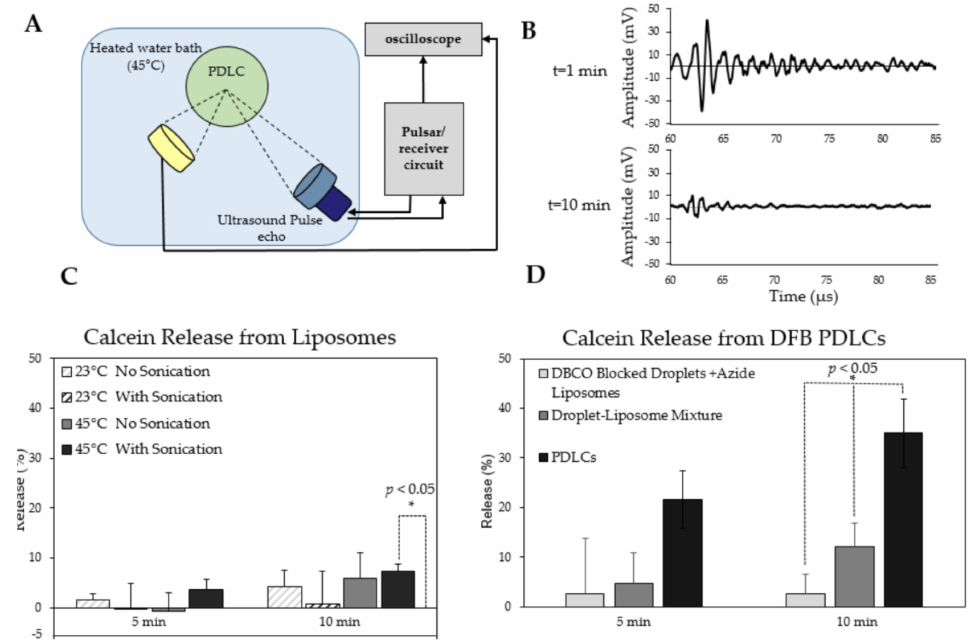
Figure 6. Calcein release from phase changeable droplet-liposome clusters (PDLCs) after 5 and 10 min of sonication ( A ) schematic illustration of the acoustic chamber setup used for measuring calcein release from PDLCs. ( B ) vaporization acoustic signals during and after vaporization used for visualizing the completion of droplet vaporization. ( C ) Effect of sonication and temperature on release from liposomes alone (no droplets). Only sonication at 45 ◦ C showed a statistically significant release above zero (* p < 0.05). ( D ) Calcein release following US exposure. Release from PDLCs was significantly higher than any other group after 10 min (* p < 0.05). Release after 5 min was higher than the negative controls but not significantly. N = 3 per